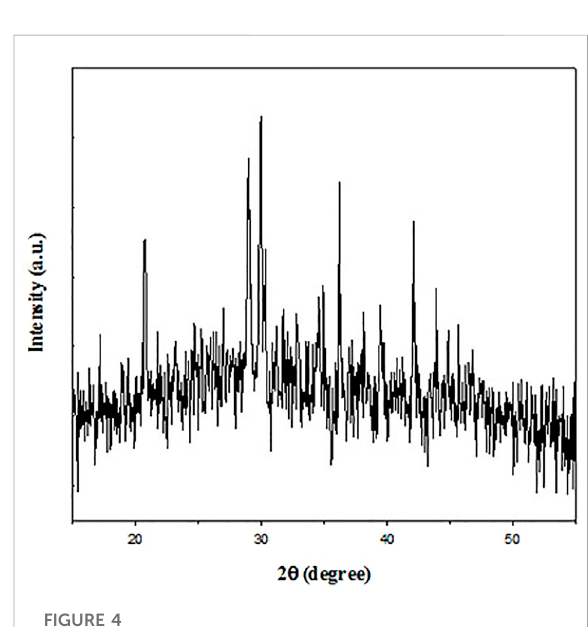
FIGURE 4 XRD spectrum of the green synthesized chromium oxide